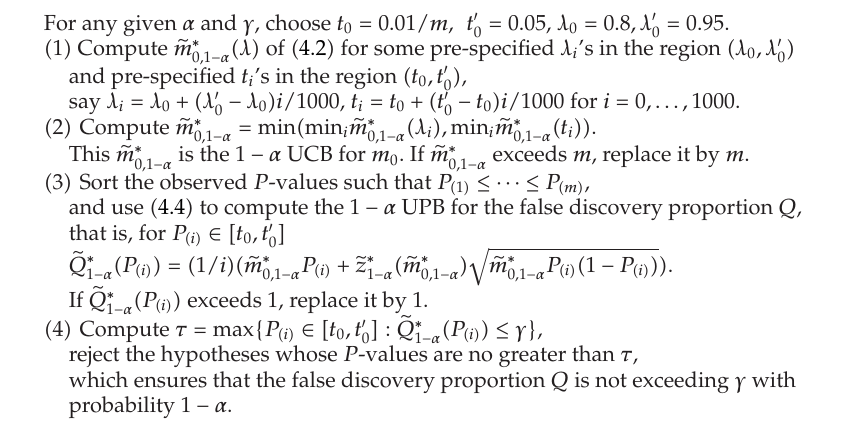
Algorithm 2: Focused simultaneous inferences on the UPBs for the false discovery proportion and the UCB for m 0